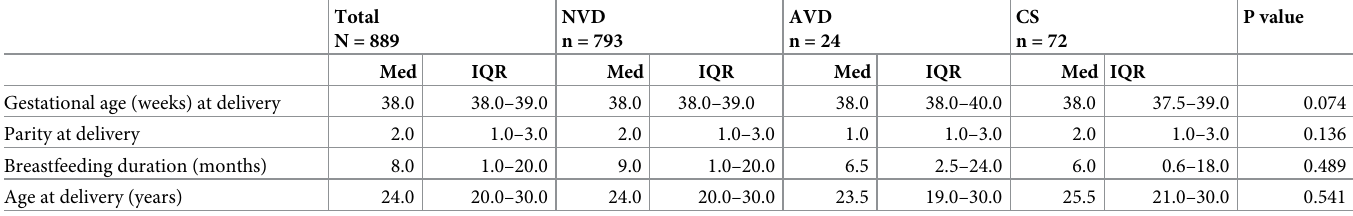
Table 4. Maternal characteristics of the study participants by mode of delivery.